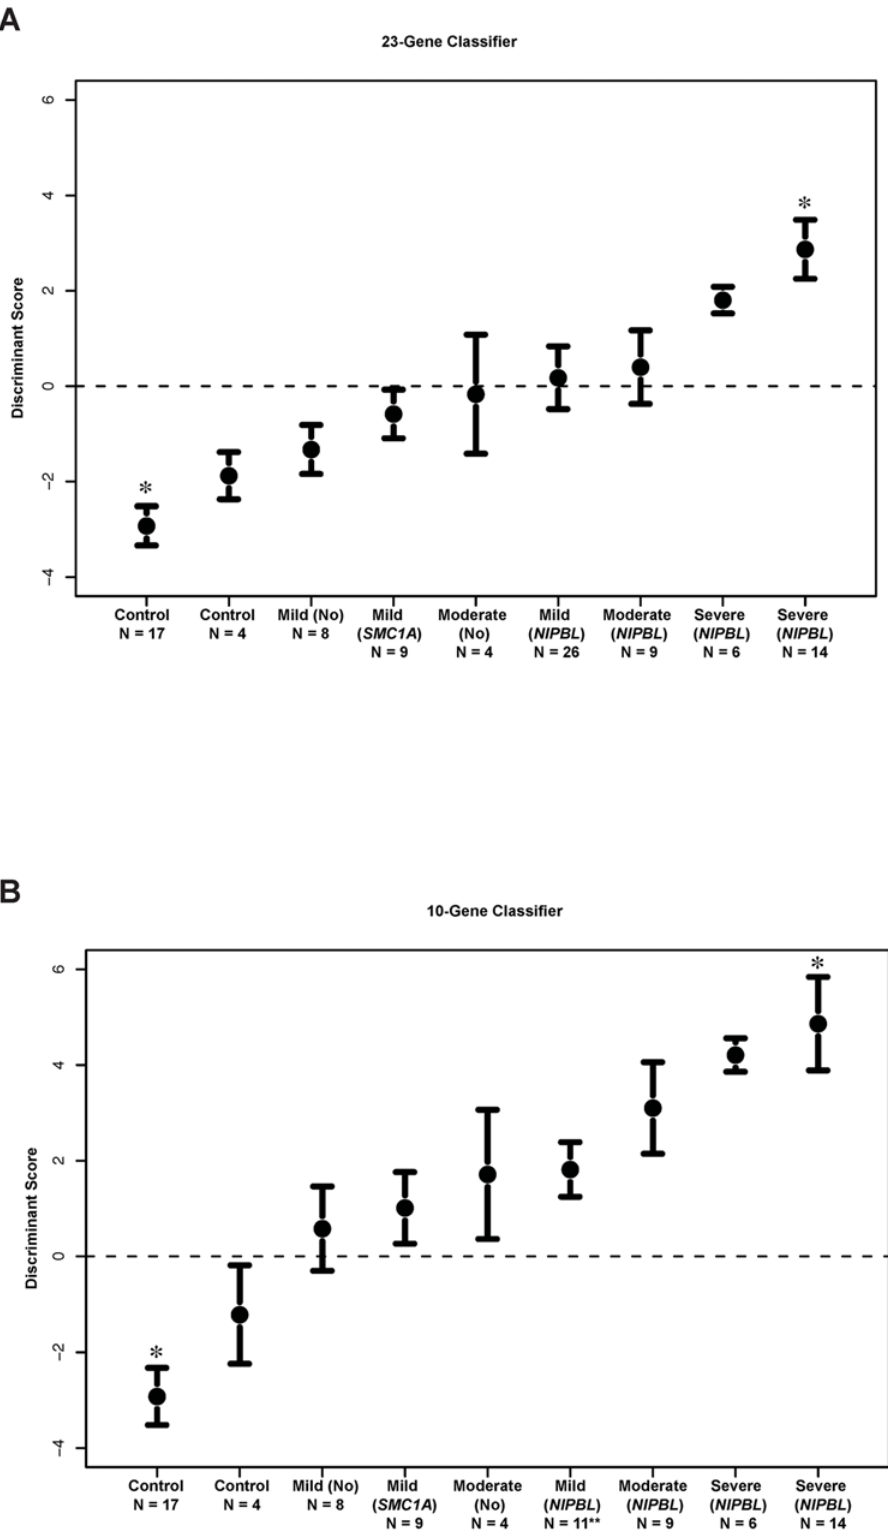
Figure 2. Classifier genes are identified for CdLS. Clear progression of discriminant score (DS) from low to high is correlated with the phenotype from unaffected R mild R moderate R severely affected with CdLS. (A) The 23-gene classifier separates CdLS probands with NIPBL mutations from the rest of the individuals. Healthy controls, probands with other genetic disorders, CdLS probands with SMC1A mutations, and CdLS probands with no gene mutation identified are distinctly separated from each other in a progressive manner correlated with phenotypic severity. (B) The ten-gene classifier differentially categorizes all CdLS probands from non-CdLS individuals and plots correlate to the severity of the CdLS probands. Healthy controls are labeled as ‘‘Control,’’ disease severity is described as ‘‘Mild,’’ ‘‘Moderate,’’ and ‘‘Severe’’ CdLS probands with NIPBL mutations, SMC1A mutations or no identified gene mutation are labeled as ‘‘ NIPBL ,’’ ‘‘ SMC1A ,’’ or ‘‘No,’’ respectively. *, training samples; **, number of mild cases with an NIPBL mutation was reduced from 26 in (A) to 11 in (B) with the other 15 cases having been used as training samples. doi:10.1371/journal.pbio.1000119.g002 PLoS Biology |